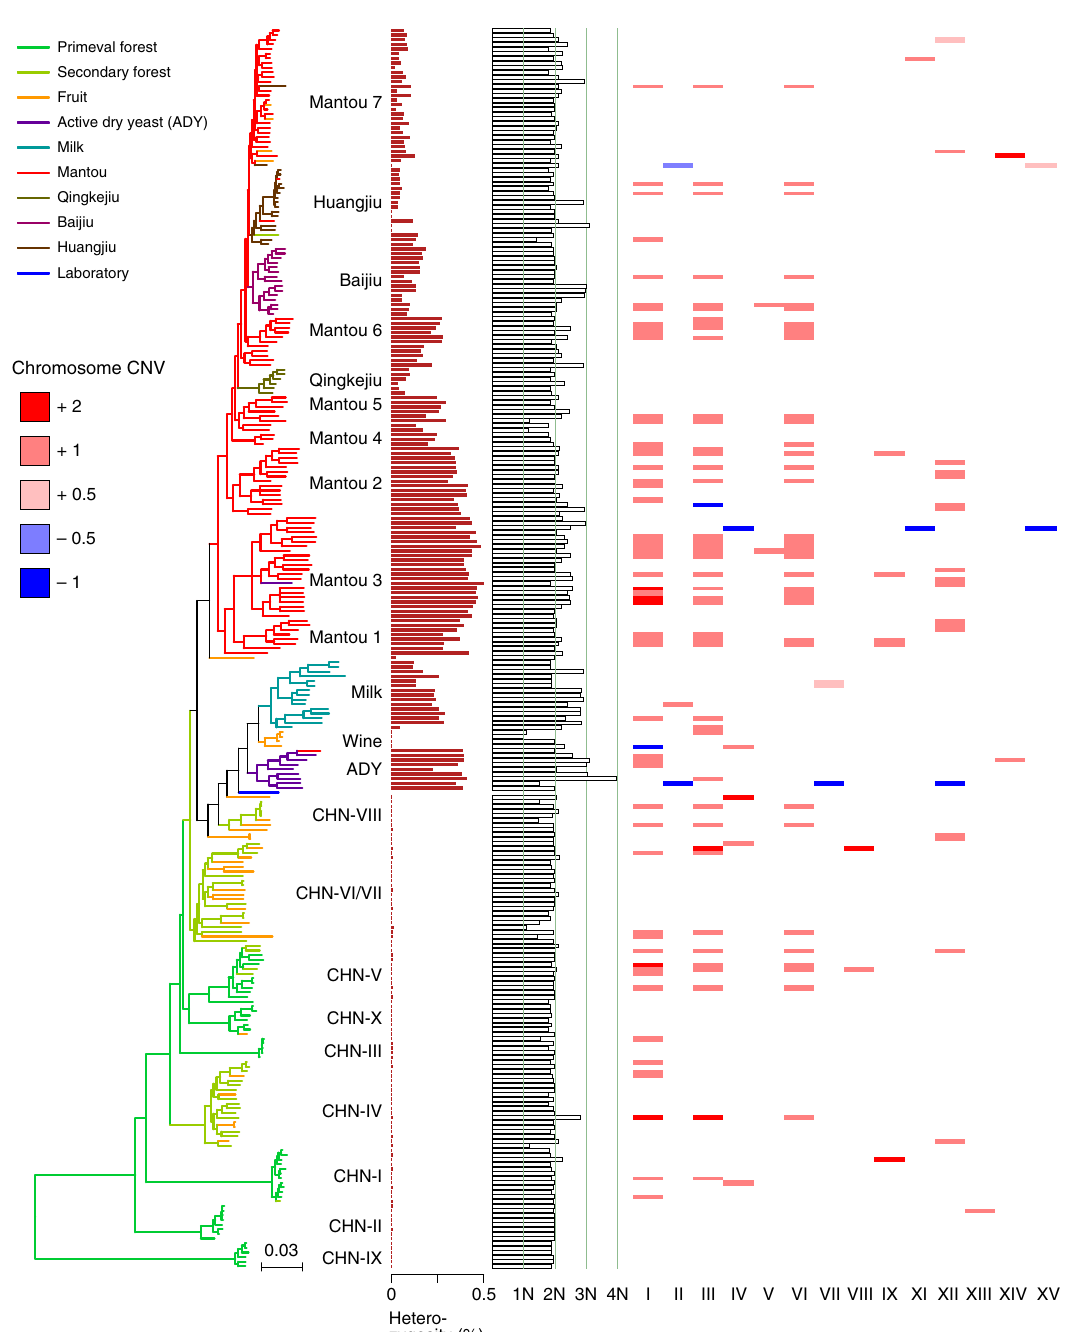
Fig. 2 Heterozygosity, ploidy, and chromosome copy-number variation (CNV) in wild and domesticated isolates of S. cerevisiae . Isolates are represented by terminal branches in the phylogenetic tree constructed from the maximum likelihood analysis on genome wide SNPs and are colored according to their ecological origins. Heterozygosity is expressed as the ratio of heterozygous SNPs to the consensus genome size of each isolate. Ploidy of each isolate was estimated using fl ow cytometry and is represented by a bar graph. Ampli fi cation of individual chromosomes above 2 n is shown by a pink or red stripe with a digital value (pink 0.5, ampli fi cation of a part of the chromosome; light red 1, one extra copy of the whole chromosome; dark red 2, two extra copies of the whole chromosome). Deletion of individual chromosome below 2 n is shown by a blue stripe with a digital value (light blue − 0.5, deletion of a part of the chromosome; dark blue − 1, deletion of one copy of the whole